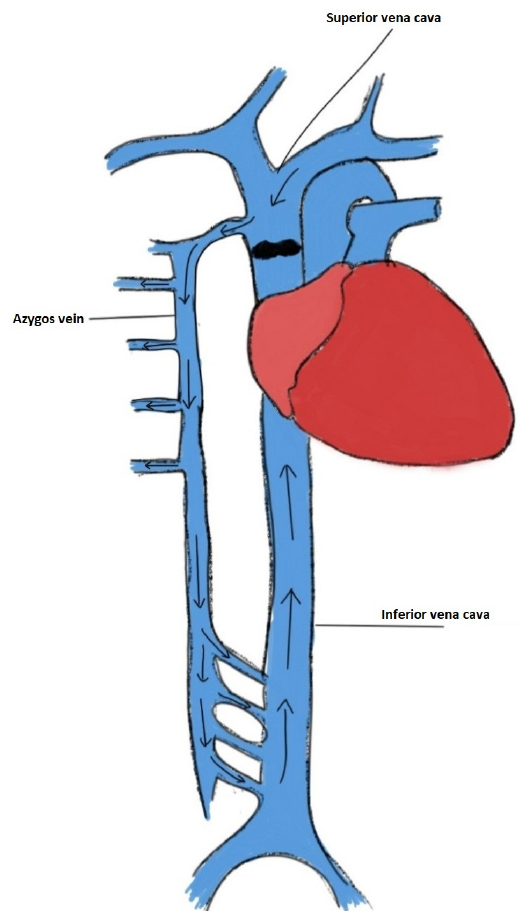
Figure 2. A demonstration of blood flow secondary to SVC